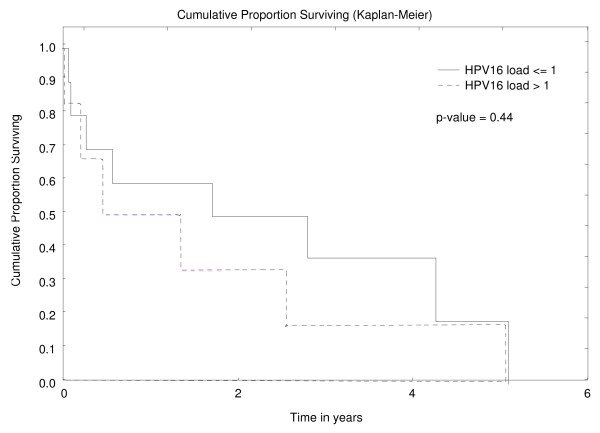
Survival analysis including sixteen HPV 16 positive cases with respect to their HPV 16 viral load, divided into HPV 16 load <1.0 genomes/human genome equivalents or HPV 16 load >1.0 genomes/human genome equivalents.